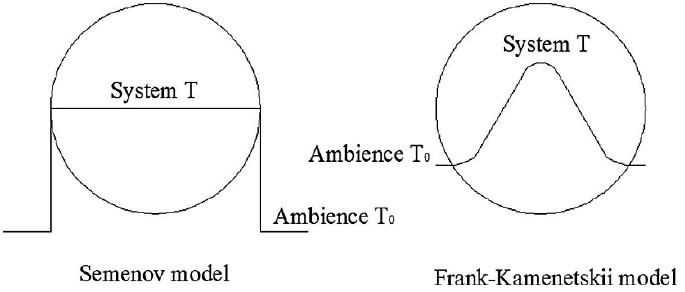
Figure 3. Temperature distributions for the Semenov and Frank–Kamenetskii models.